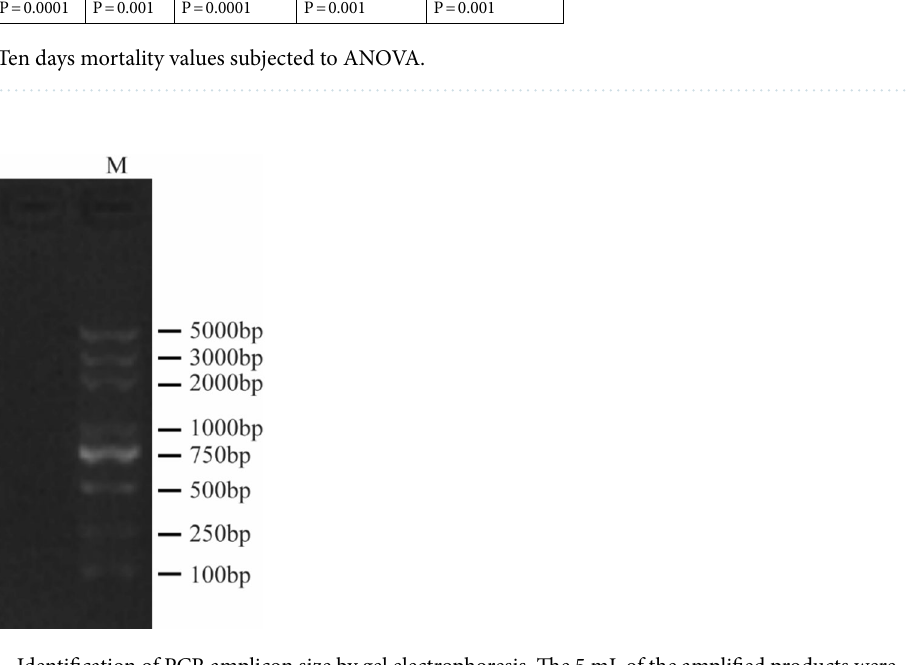
Figure 10. Identification of PCR amplicon size by gel electrophoresis. The 5 mL of the amplified products were used for 1% agarose gel electrophoresis. The size of the extracted fragment was between 100 and 250